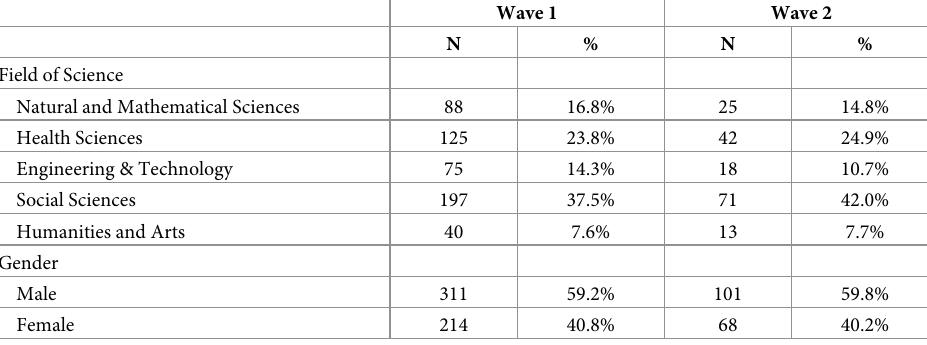
Table 1. Sample characteristics by field of science and